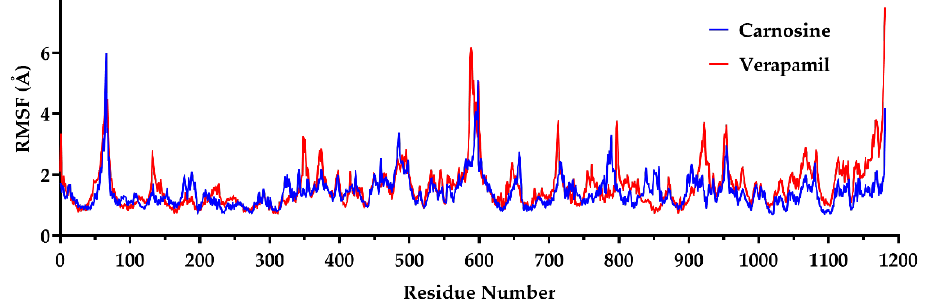
Figure 2. The root mean square fluctuation (RMSF) of carnosine-(blue line) and verapamil-bound (red line) P-glycoprotein (P-gp) during 200 ns molecular dynamics simulation. The PDB file 6QEX was selected as a template of P-gp and used for molecular dynamics simulations in the presence of either carnosine or verapamil for 200 ns using the Desmond package of Schrödinger, as described in further detail in Section 4.